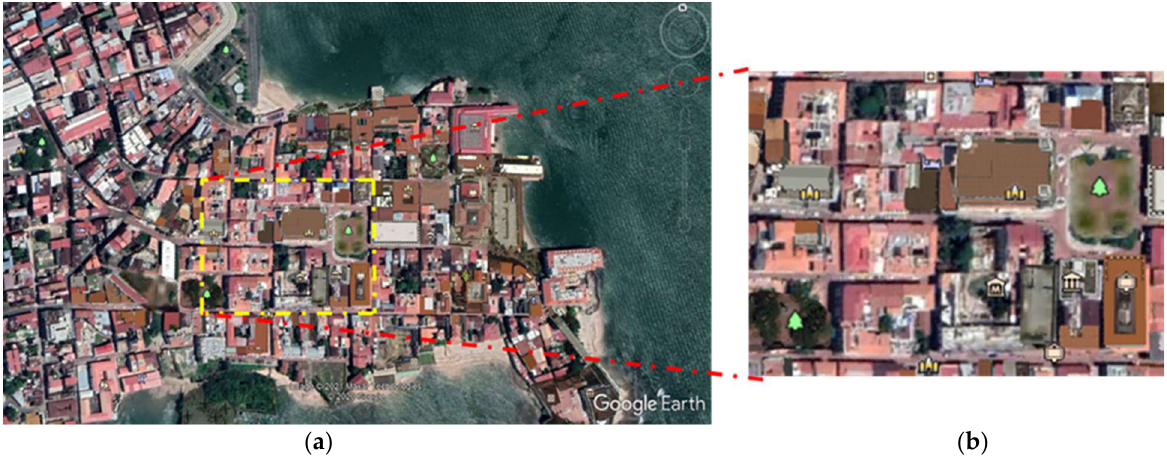
Figure 2. ( a ) Satellite view of the Casco Antiguo; ( b ) Studio cutout view (290 × 226 m).